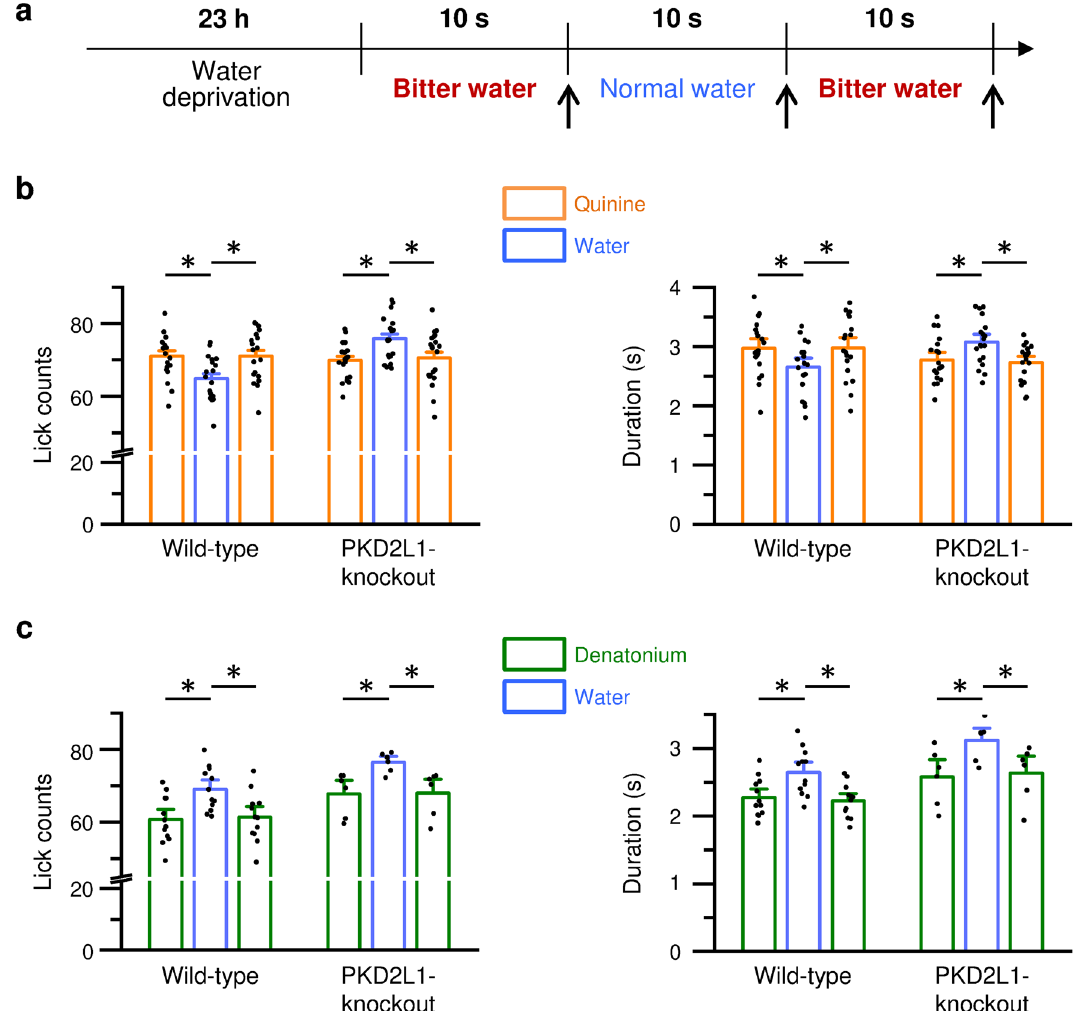
Figure 6. Lick behaviors to quinine or denatonium in mice. ( a ) Timeline of experimental protocols. Arrows indicate the time that a bottle was replaced. The counts and duration of licks were measured for each 10 s. ( b , c ) Lick counts (Left) and duration (Right) during the alternate presentation of 30 µM quinine-containing water and normal water ( b ) or 500 µM denatonium-containing water and normal water ( c ) in the wild-type and the PKD2L1-knockout mice. The data are averaged from 6 to 21 experiments. P values are determined by paired two-tailed Student’s t-test (n = 19/WT and n = 21/KO in b , n = 12/WT, and n = 6/KO in c ). *, P <